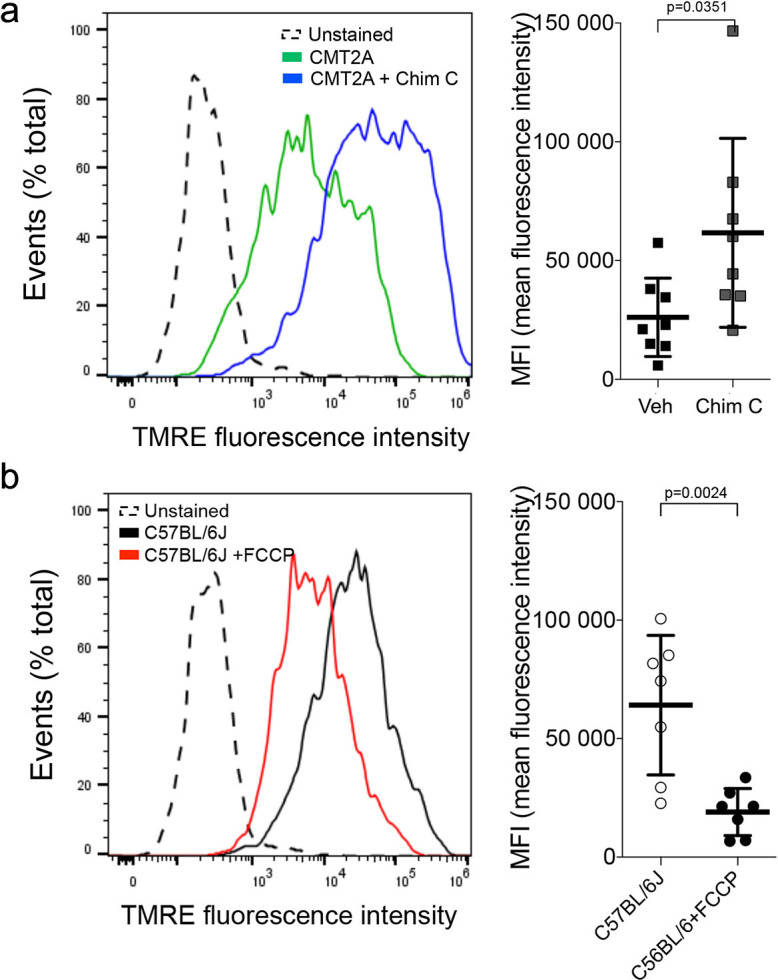
Flow cytometric profiling of mitochondrial polarization status in mouse dorsal root ganglion (DRG) neurons.(a) DRGs from CMT2A MFN2 T105M mice. Left is representative mitochondrial gating by TMRE fluorescence from a single study; green is vehicle; blue is Chimera C (100 nM, 48 hr). Right graph shows geometric mean fluorescence intensity (MFI) for eight experiments. TMRE fluorescence is inversely proportional to depolarization; increased fluorescence indicates respiratory fitness. (b) Control studies as in a. using DRGs from normal C57BL/6J mice. FCCP is a depolarizing agent used as a positive control. P values by t-test.